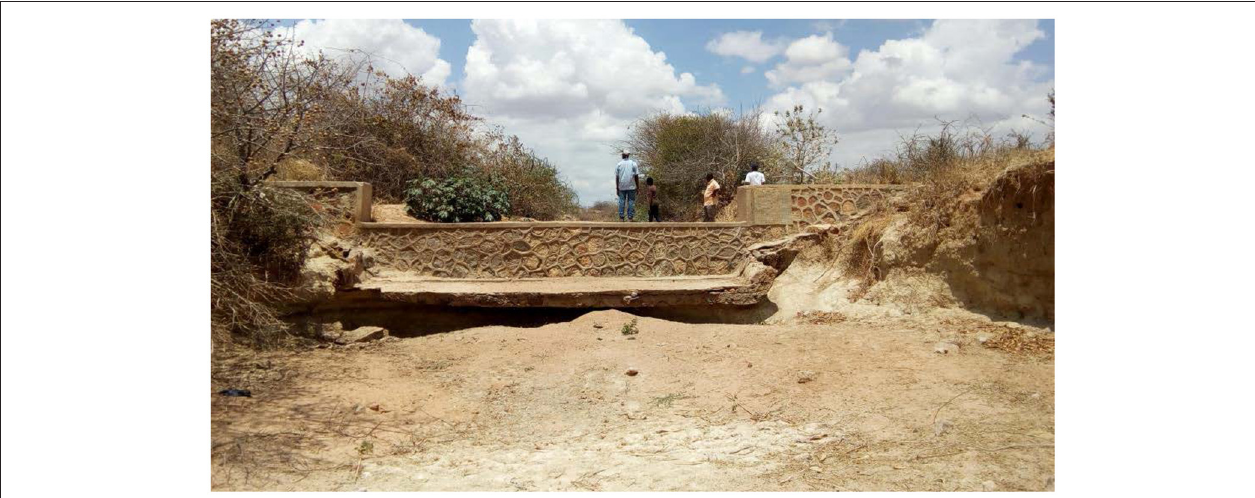
FIGURE 4 | Mshikamano sand dam near Dodoma, Tanzania exhibiting significant erosion of the apron and left streambank. Photograph taken while looking upstream during the dry season. Photo credit: J. A.